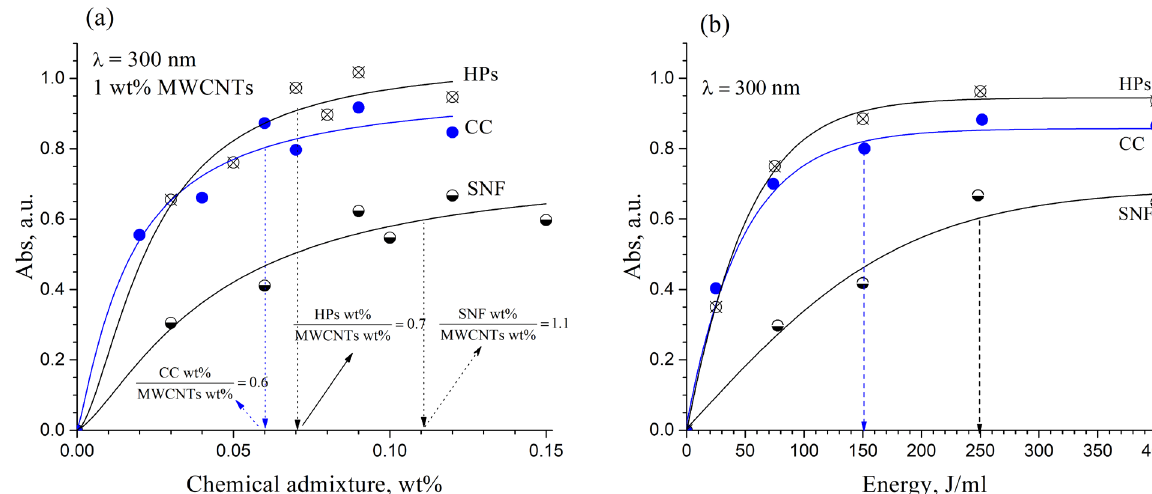
O+CAd] solutions, and (b) [H 2